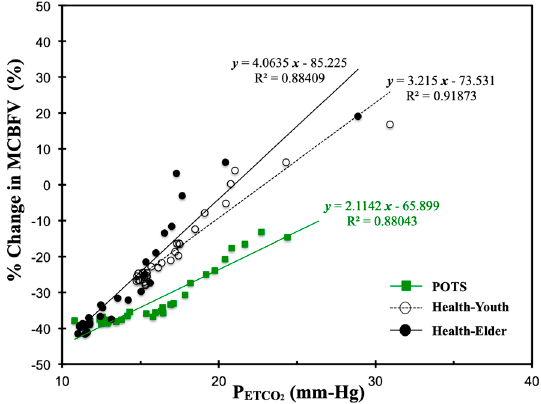
Figure 6. Linear analysis of averaged percentage change in MCBFV to CO 2 for the three subject groups during 30 s of hyperventilation.